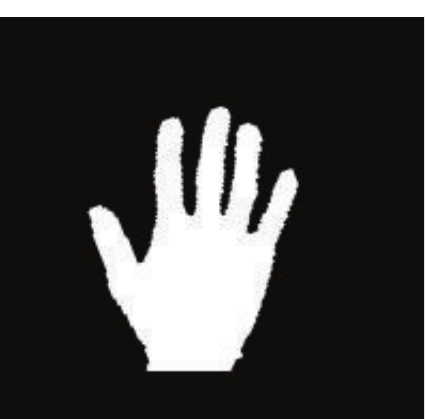
Figure 6: The palm point, wrist points, the wrist line, and the inner circle of the maximal radius.